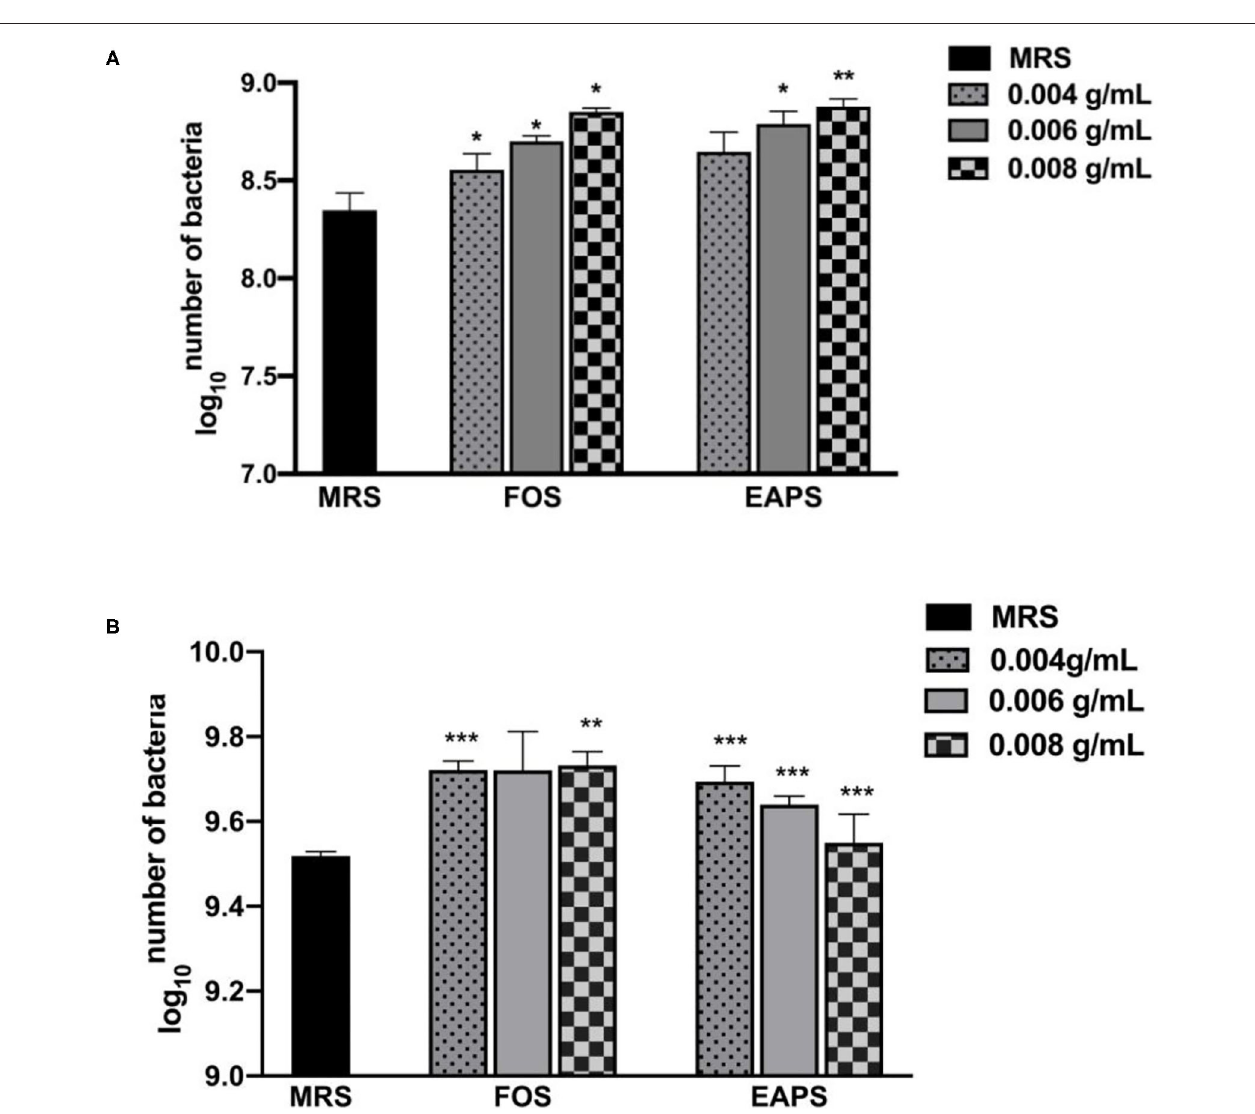
FIGURE 3 | Prebiotic effects of EAPS on Lactobacillus acidophilus (A) and Lactobacillus plantarum (B) . de Man, Rogosa, and Sharpe Broth (MRS Broth) is the blank control; fructooligosaccharides (FOS) are a positive control. All tests were performed in triplicate and repeated at least once, and the results were expressed by their means ± SD. Statistical significance of the treatment effects was determined by Duncan’s multiple range t -test (* p < 0.05, ** p < 0.01, and *** p <